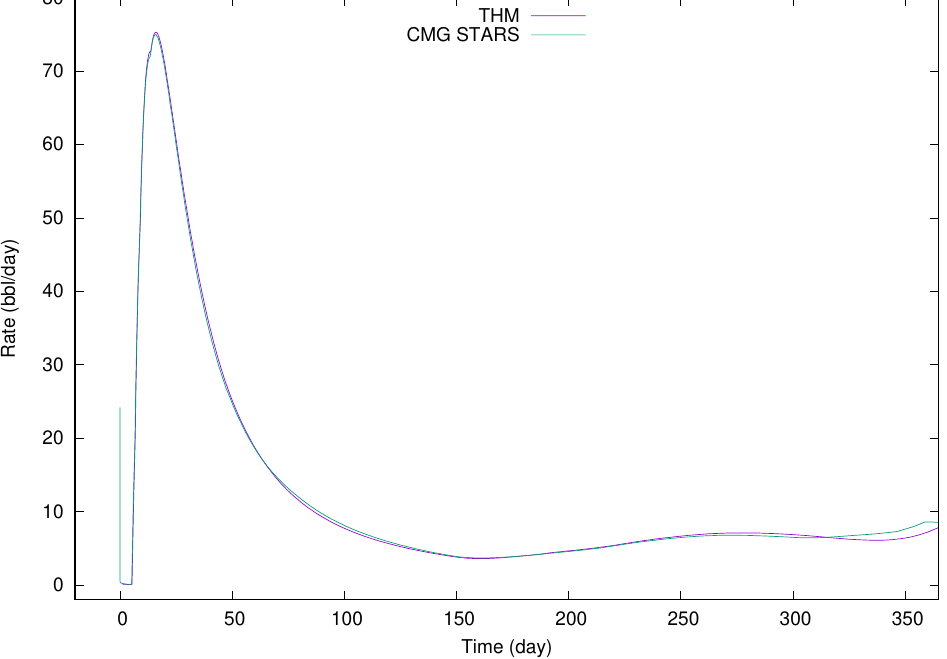
Figure 11. Example 2: total water production rate (bbl/day).